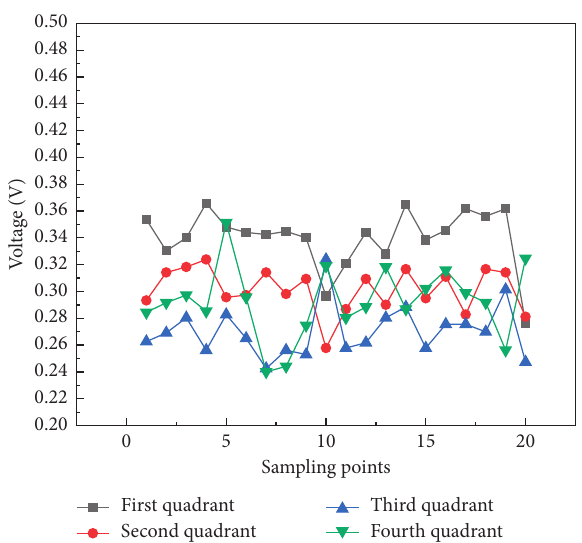
Figure 7: Voltage value of each quadrant after